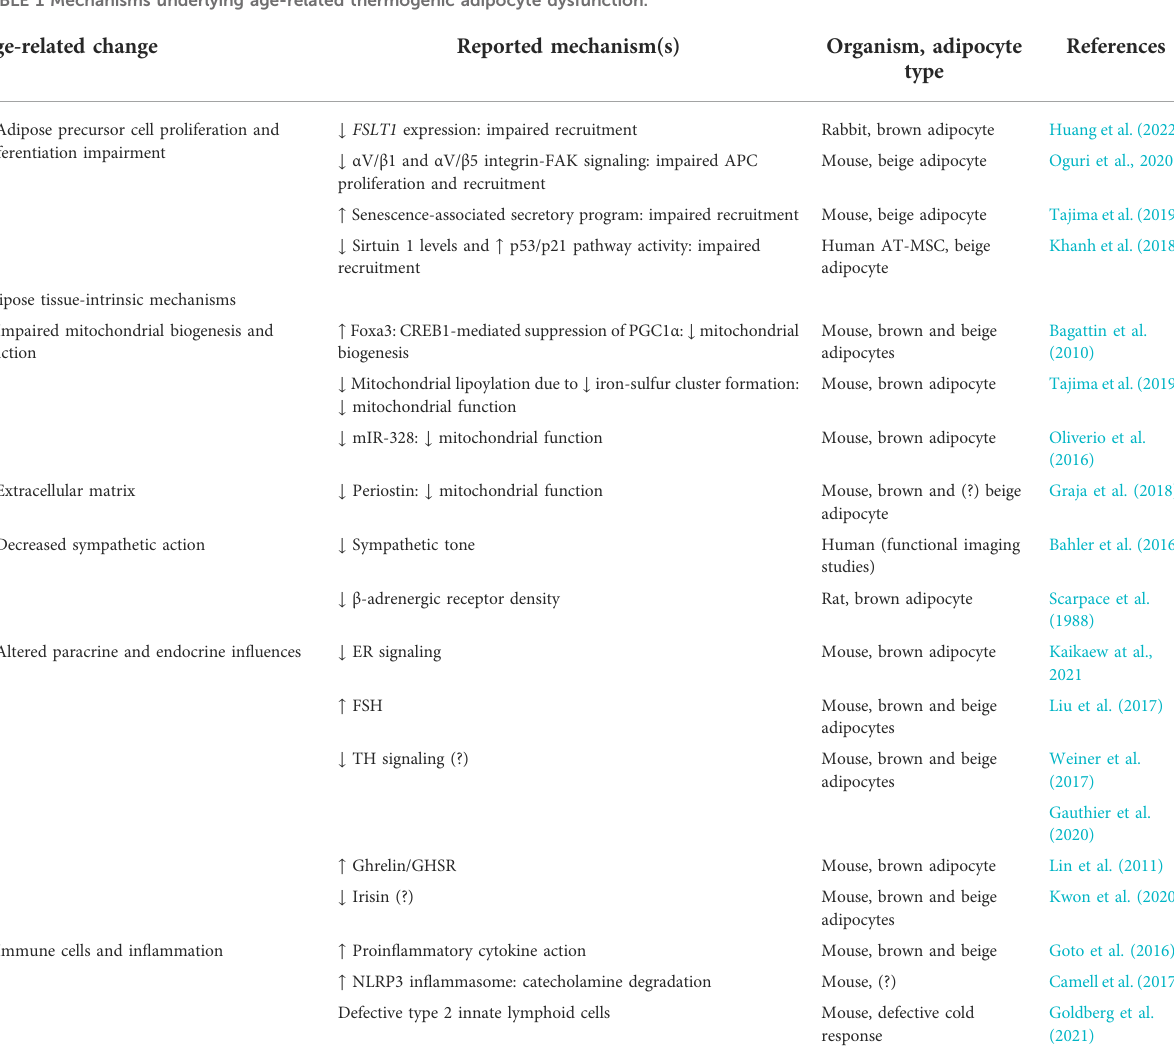
TABLE 1 Mechanisms underlying age-related thermogenic adipocyte